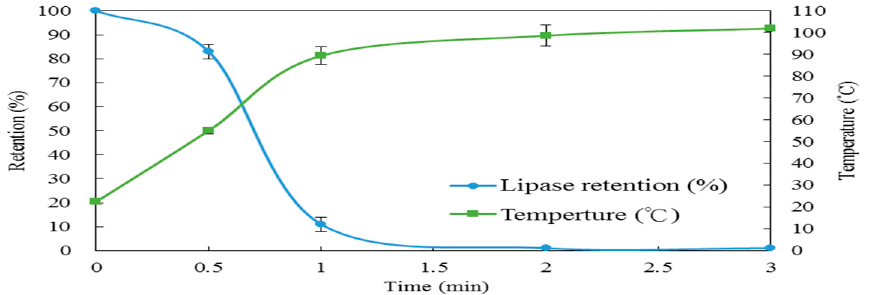
Figure 2. The temperature profile and lipase inactivation during RF for the 6 cm electrode gap with a 1 kg rice bran package. Data are expressed as the mean ± SD ( n = 3).